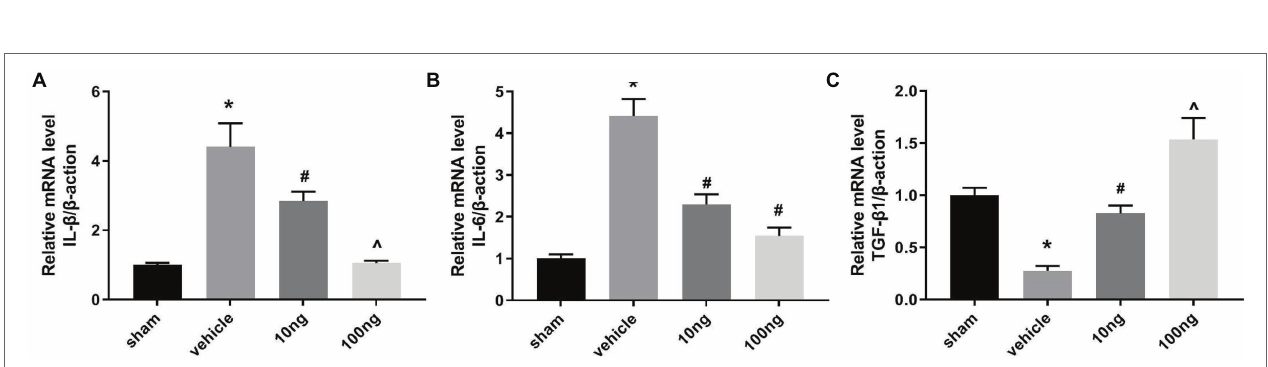
FIGURE 2 | Protectin DX prominently regulated the mRNA productions of cytokines ( n = 5/group). (A–C) Real-time polymerase chain reaction (RT-PCR) were executed to measure the inflammatory cytokines’ mRNA levels. Intrathecal delivery of PDX (10 ng or 100 ng) suppressed the mRNA levels of IL-1 β and IL-6, and facilitated the mRNA expressions of TGF- β 1 . One-way ANOVA was used for comparisons among groups followed by Turkey’s multiple comparison test; Data are presented as mean ± SEM (* p < 0.05 vs. sham group; # p < 0.05 vs. vehicle group; ^ p < 0.05 vs. 10 ng